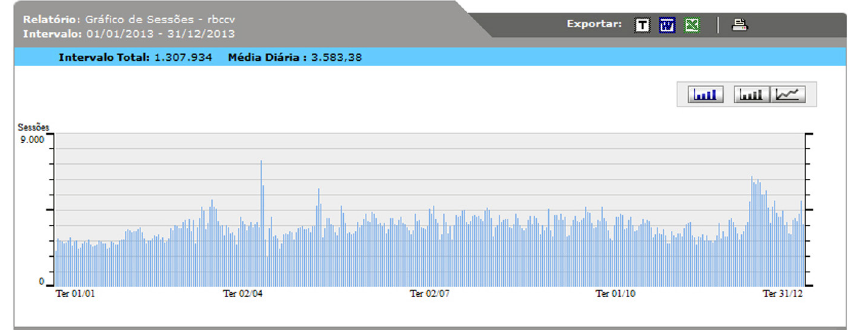
Fig. 1 – Graph showing the access to the RBCCV / BJCVS site in 2013.